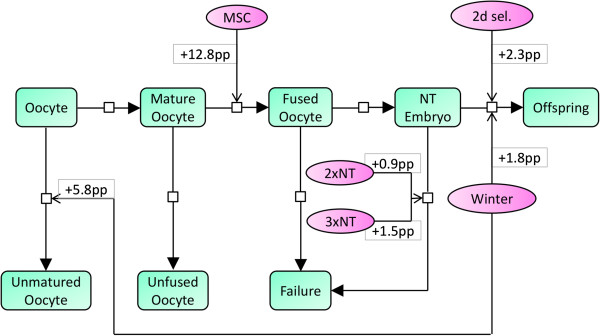
The major statistical effects of the investigated factors on the development from in vitro oocyte maturation to cloned offspring. According to the results listed in Tables 3, 4, 5, 6, and 7, transitions between developmental stages (green rectangles) are found to be affected by statistically significant impact categories (purple ellipses). For each impact, the gain during a certain transition is given in percentage points (pp) and as compared to the corresponding reference. For example, the cloning efficiency (offspring out of transferred embryos, including only recipients that delivered) is increased by 1.8 pp in winter (from 3.5% to 5.3%), as compared to spring, which was used as reference. MSC: mesenchymal stem cells, 2d sel.: selected embryos for initiation of development on day 2 (2-cell to 4-cell stage), NT: nuclear transfer.